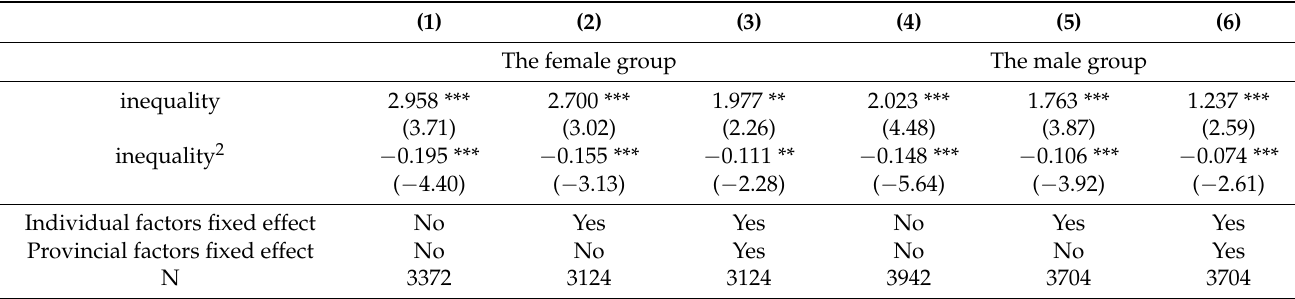
Table 11. The effect of individual-level income inequality on subjective environmental pollution: differences in